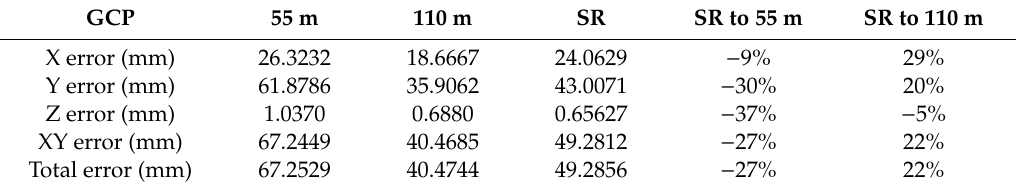
Table 4. GCP locations, error estimates, and percentage di ff erence calculations for the Mavic Pro. GCP 55 m 110 m SR SR to 55 m SR to 110 m